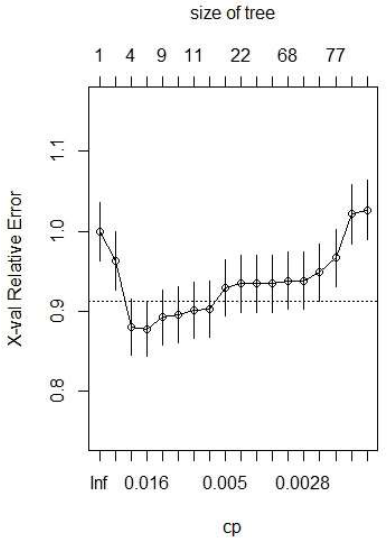
Figure A1. Plot of the cross-validation relative error rate for trees of increasing size (top X -axis) and the corresponding cost-complexity values (bottom X -axis).